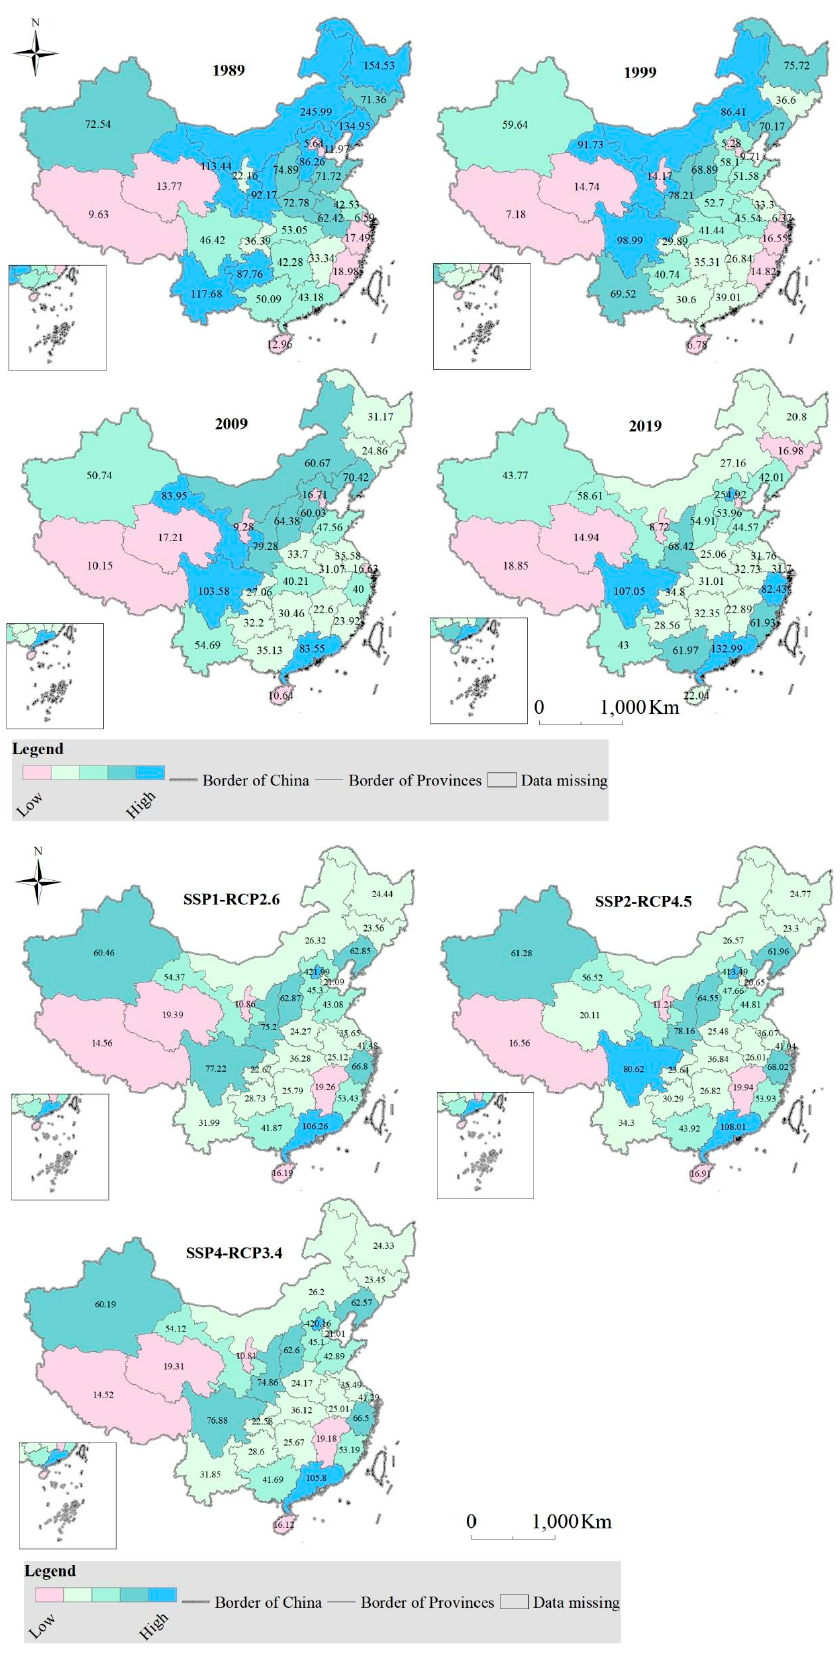
Figure 4. Cropland needed by people, and the value (unit: 10 5 ha) in the map stands for the amount of cropland required by people in each province.